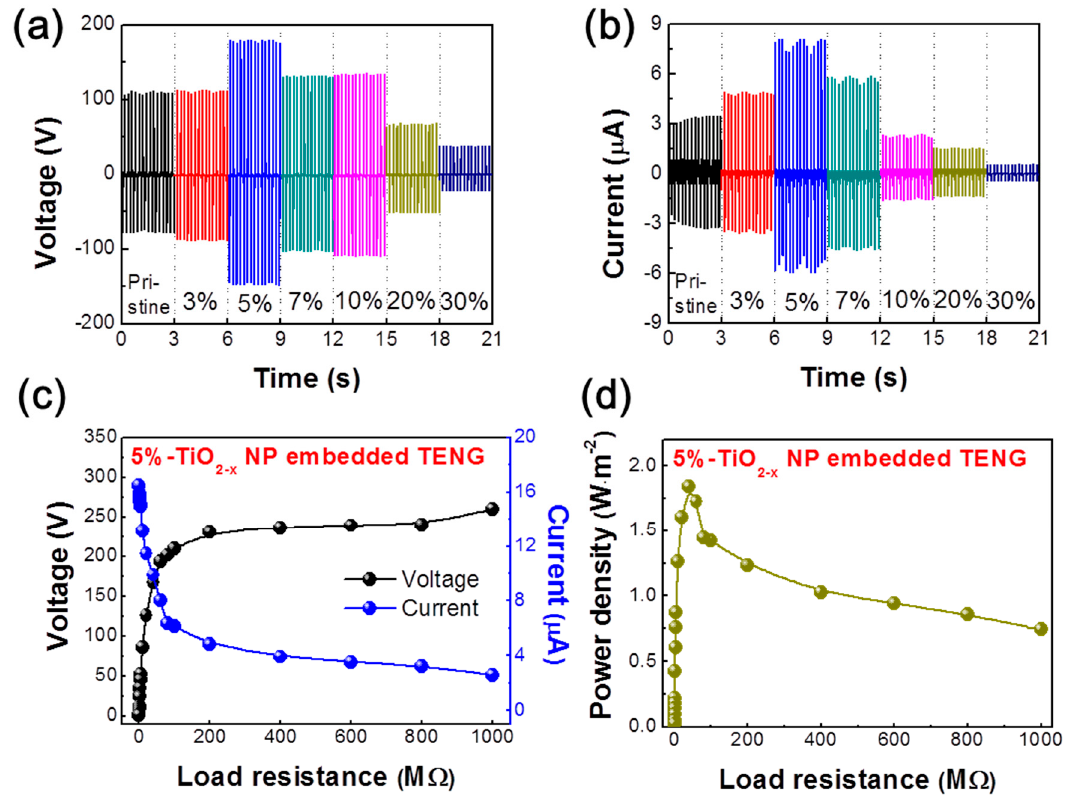
Figure 2. Effects of the output power of TENGs caused by embedded TiO 2 − x NPs. ( a ) Output voltage and ( b ) current of the TiO 2 − x NP embedded TENGs as a function of the TiO 2 − x NPs embedded weight ratio (measured under a relative humidity of ~55%). Influence of external load resistance on the ( c ) output voltage/current and ( d ) power density of the TENG under a pushing force of 5 N and a pushing frequency of 5 Hz.